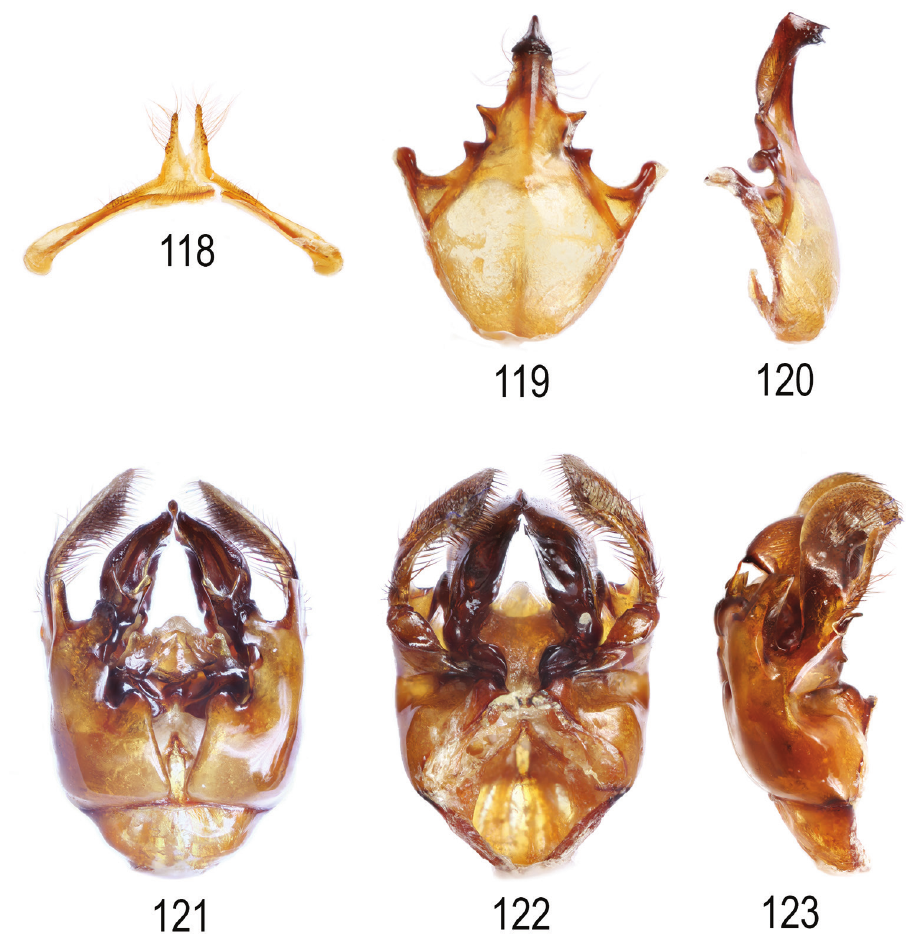
Figures 118–123. Male terminalia of E. micheneri (paratype. Mexico: Jalisco, Talpa, KUNHM-ENT 1121712). 118 Seventh metasomal sternum in ventral view 119, 120 Eighth metasomal sternum in ventral and lateral views 121–123 Genital capsule in dorsal, ventral, and lateral